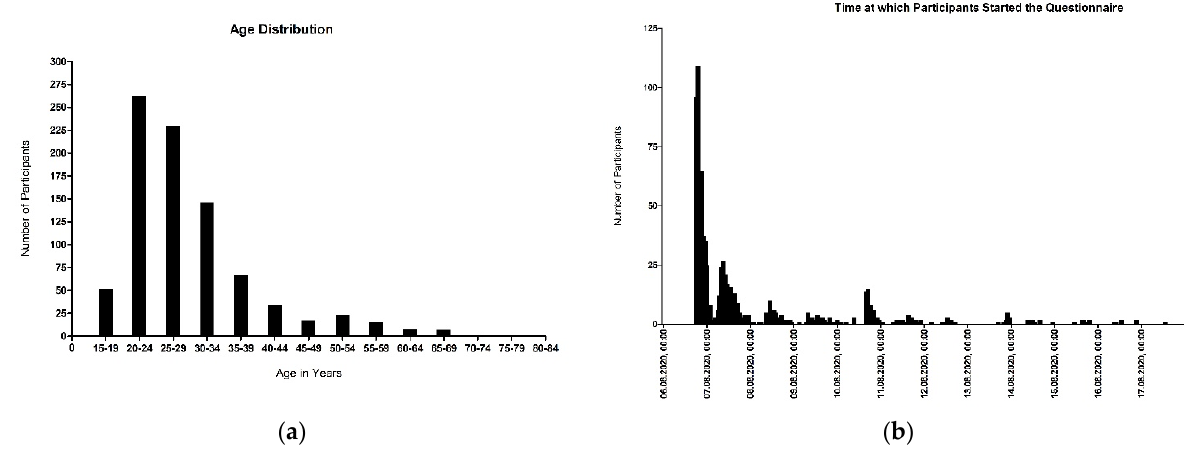
Figure 1. ( a ) Age distribution of participants; ( b ) Date and time when participants started the questionnaire.